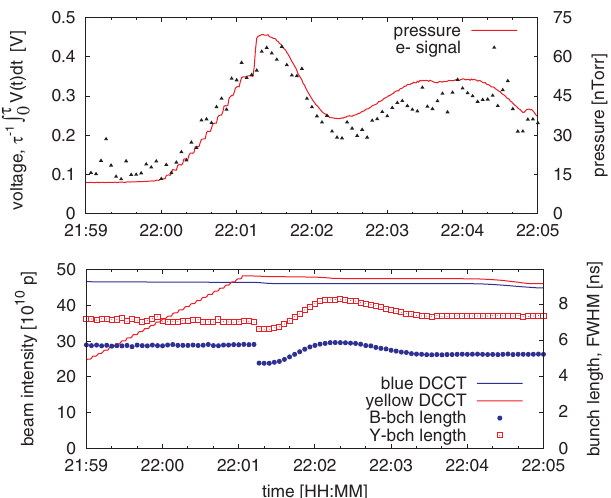
FIG. 9. (Color) Dynamic pressure evolution and electron signal (top plot), as the blue beam is being injected and ramped (bottom plot). At the beginning of the energy ramp (22:01:20) the rf voltage is raised leading to shorter pressure evolution (top plot), as the bunch length (denoted with blue and red squares for the blue and yellow beam, respectively) swings during the ramp (bottom plot).